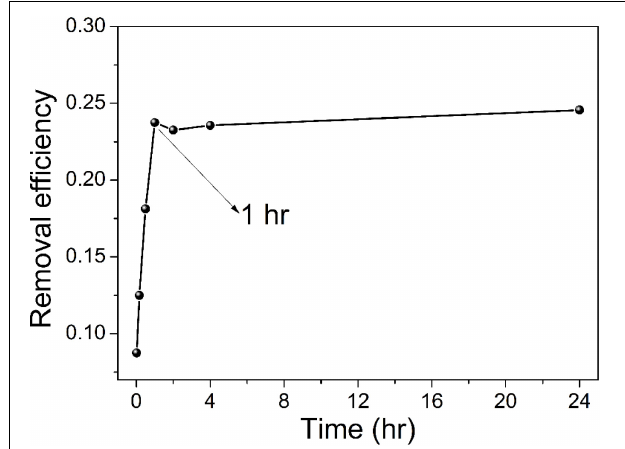
FIGURE 5 | The relationship between uranium removal efficiency by TiO 2 /Ti and contact time ( T = 298 K, pH 5.0, C 0 = 40 mg L − 1 , mixing time 1–1,440 min, and amount of TiO 2 /Ti 0.025